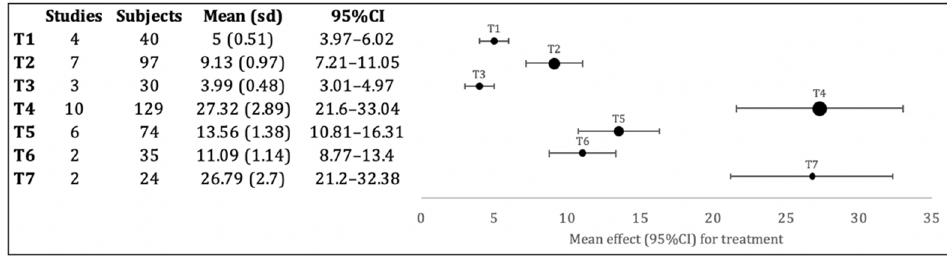
Figure 3. Forest plot of brackets adhesion to feldspathic ceramics with diverse superficial treatments. T1: Fine bur group; T2: Sandblasting (Al 2 O 3 ) group; T3: orthophosphoric acid group; T4: hydrofluoric acid group; T5: LASER group; T6: Sandblasting (Al 2 O 3 ) with hydrofluoric acid group; T7: LASER with hydrofluoric acid group. For each surface treatment, the number of studies included, the totality of samples evaluated, mean and standard deviation (SD), and 95% confidence intervals are described. Adhesion values are presented in MPa.